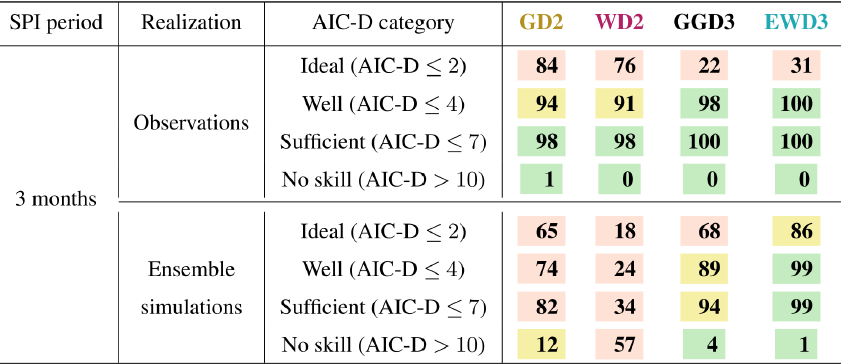
Table 3. Percent of grid points that are classified into specific AIC-D categories (according to Burnham and Anderson, 2002) for each candidate PDF over both seasons. Percentages of grid points indicate the confidence in candidate PDFs to overall performance according to the respective AIC-D category. We consider percentages that exceed (subceed in case of AIC-D values beyond 10) 95% (5%) as a sign of substantial confidence in the candidate PDF (green) to overall performance according to the respective AIC-D category. In contrast, we consider those candidate PDFs that exceed (subceed) in 85% (15%) of the grid points as a sign of average confidence in the candidate PDF (yellow) to overall performance according to the respective AIC-D category. Percentages that fall short of 85% (or that show no skill in more than 15%) are considered as an overall sign of insufficient confidence in the candidate PDF